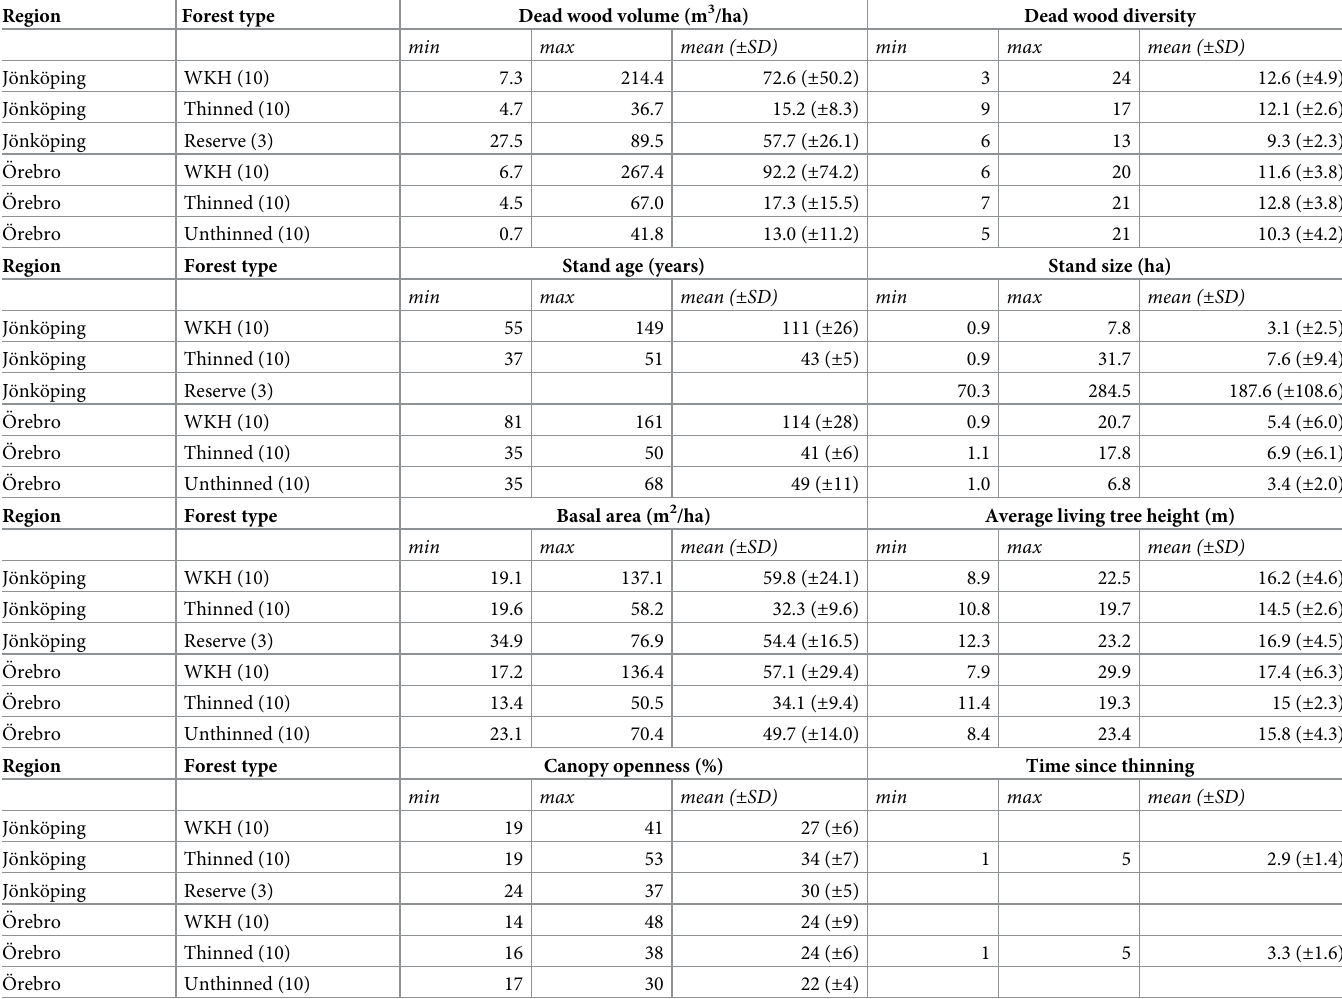
Table 1. Stand characteristics. Descriptive statistics for environmental factors and stand characteristics per forest type and region. The number of stands of each forest type per region is given in parentheses. WKH = Woodland Key Habitat.